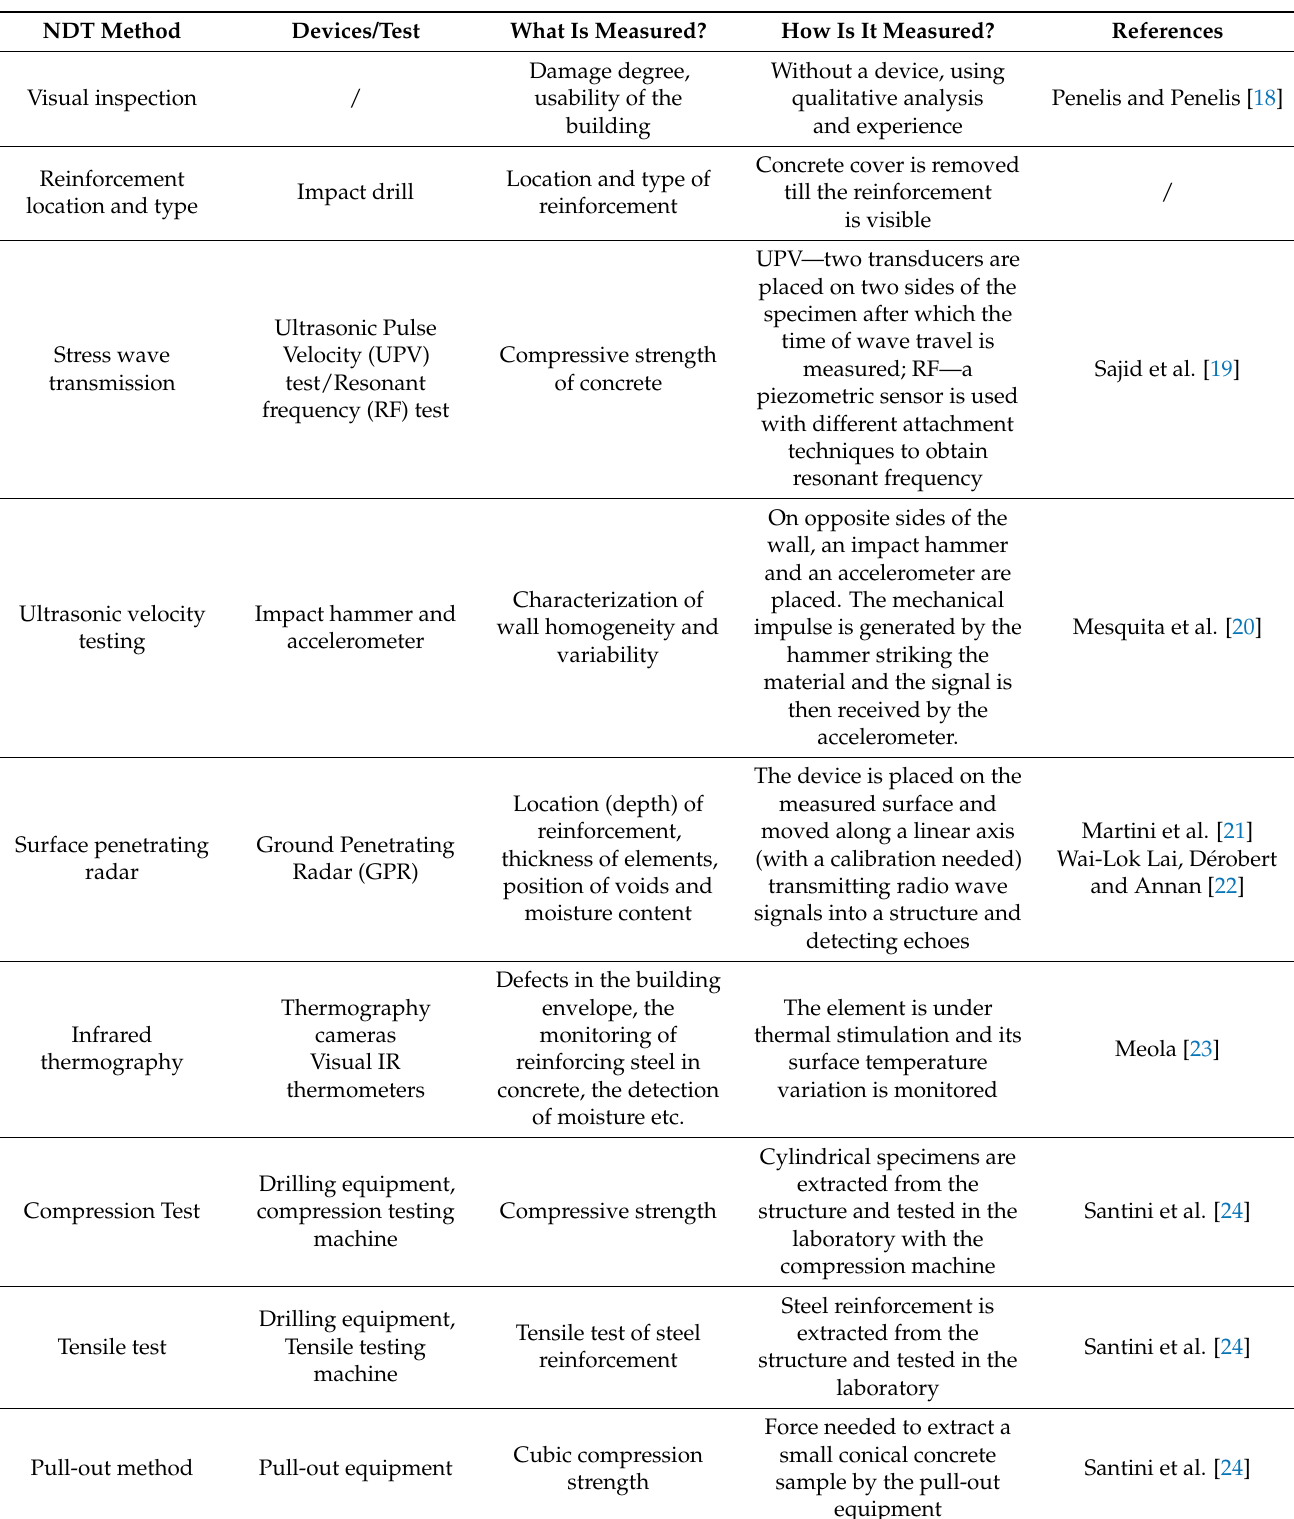
Table 1. Available non-destructive testing (NDT) assessment methods for existing RC